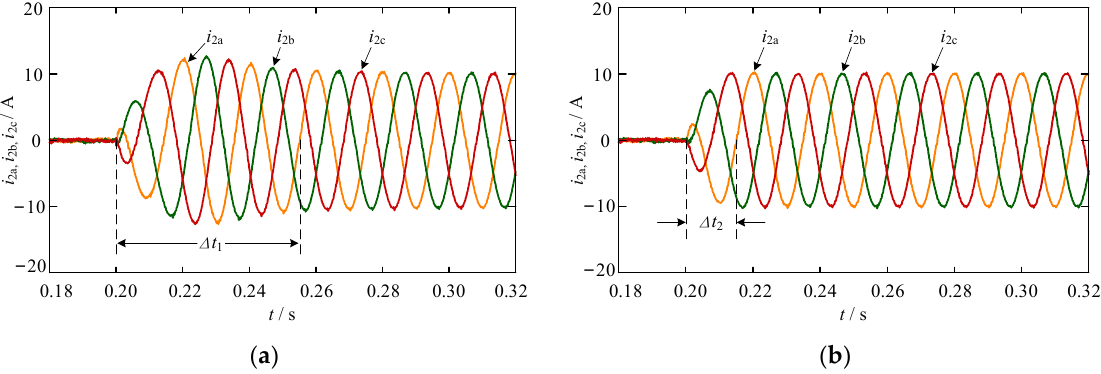
Figure 12. Simulation results comparison of the dynamic response performance: ( a ) Traditional method; ( b ) proposed method.